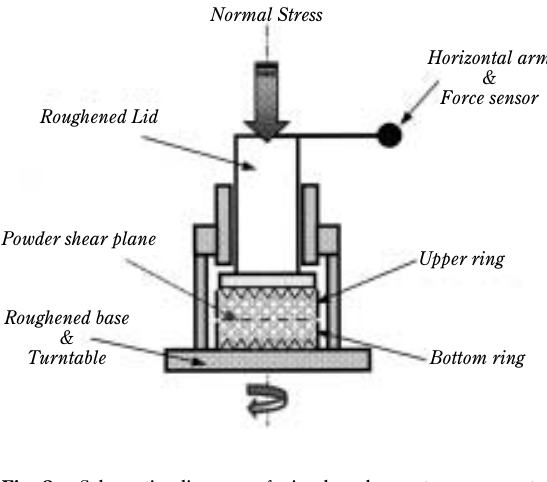
Fig. 2 Schematic diagram of circular shear stress apparatus